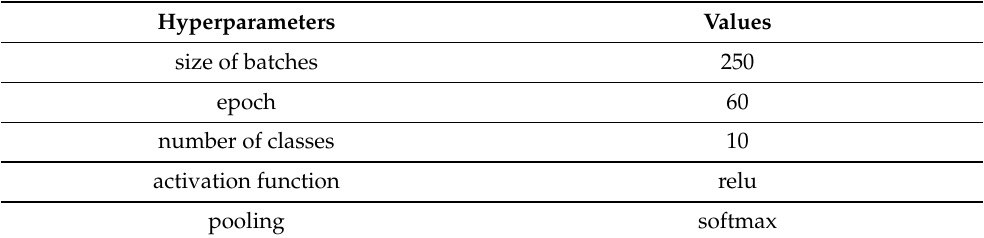
Table 2. Hyperparameters with their